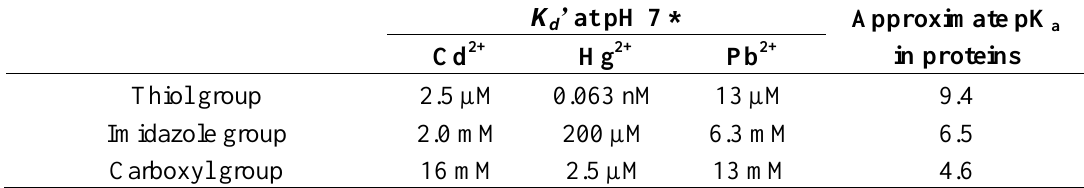
Table 1. Dissociation equilibrium constants of monodentate metal